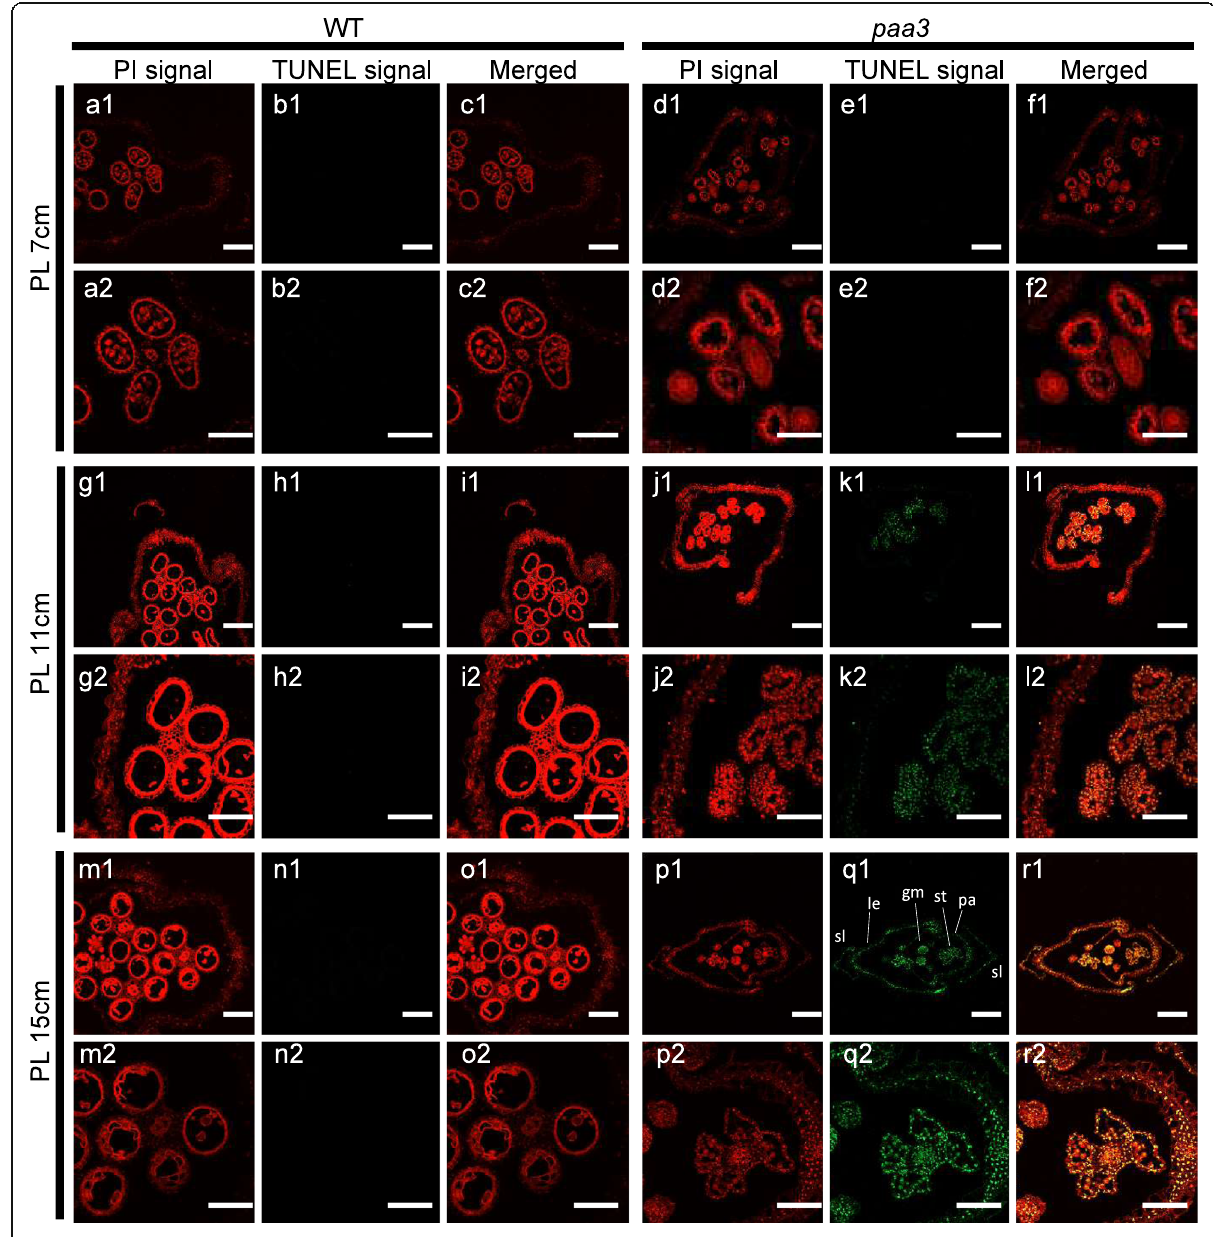
Fig. 5 Detection of DNA fragmentation by the TUNEL assay. Green fluorescence indicates TUNEL-positive signals for DNA fragmentation, red fluorescence indicates staining of spikelets and with propidium iodide (PI), and yellow fluorescence results from overlay of green signals of TUNEL and red signals of PI staining. a 1 – c 1: Top spikelets of WT in panicle length at 7 cm. a 2 – c 2 enlargement of region ( a 1 – c 1). d 1 – f 1: Top spikelets of paa3 in panicle length at 7 cm. d 2 – f 2 enlargement of region of ( d 1 – f 1). g 1 – i 1: Top spikelets of WT in panicle length at 11 cm. g 2 – i 2 enlargement of region ( g 1 – i 1). j 1 – l 1 Top spikelets of paa3 in panicle length at 11 cm. j 2 – l 2 enlargement of region of ( j 1 – l 1). m 1 – o 1: Top spikelets of WT in panicle length at 15 cm. m 2 – o 2, enlargement of region ( m 1 – o 1). p 1 – r 1: Top spikelets of paa3 in panicle length at 15 cm. p 2 – q 2 enlargement of region of ( p 1 – q 1). Bars: ( a 1 – r 1) 50 μ m; ( a 2 – r 2) 10 μ m. st: stamens; gy: gynoecium; sl: sterile lemma; le: lemma; pa: